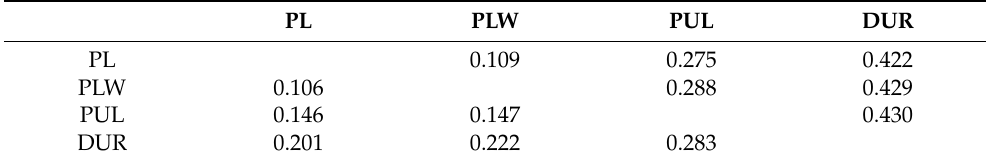
Table 2. Reynolds genetic distance ( θ w) and pairwise estimates of genetic differentiation ( F ST